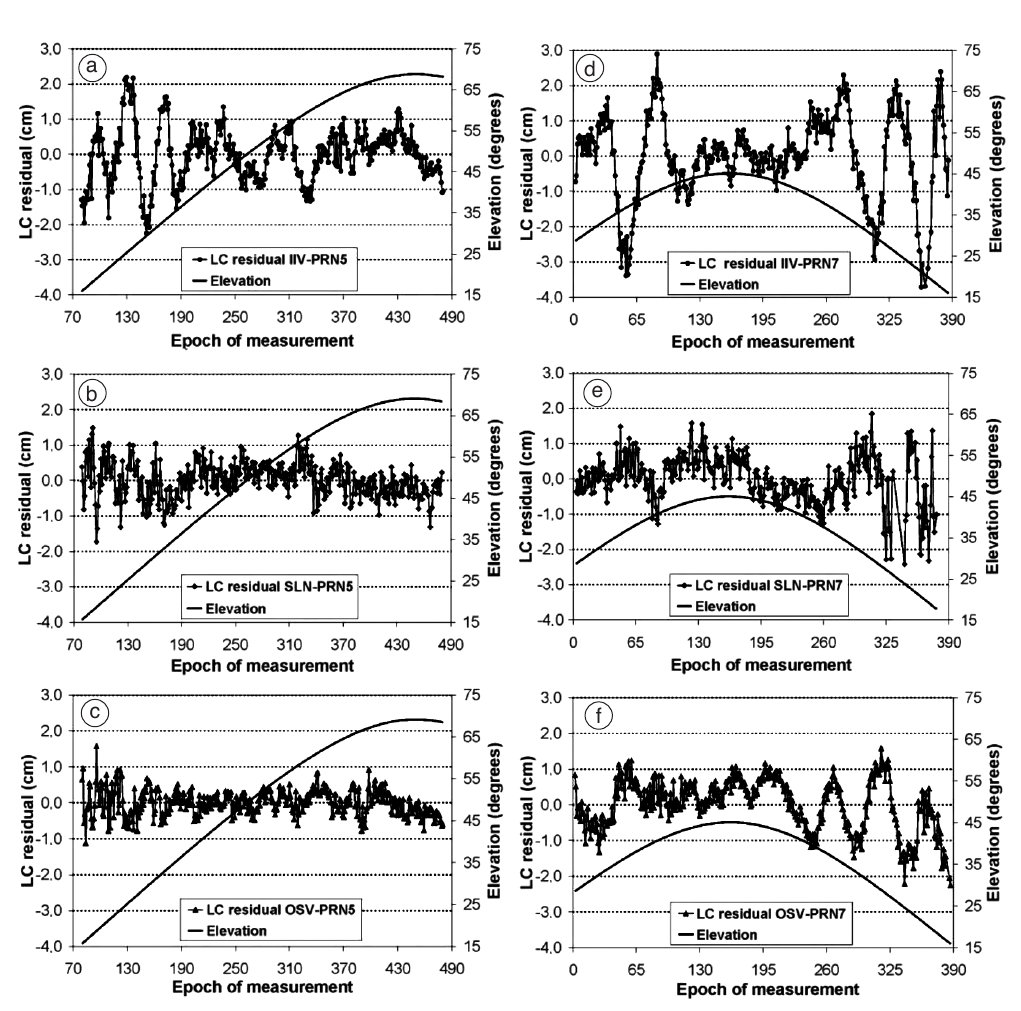
Fig. 6a-f. Residuals for the satellites PRN5 and PRN7 and the stations IIV, SLN and OSV with respect to the epoch of measurement; in the secondary ordinate axes the elevation angles of satellites are reported. For brevi- ty’s sake, we have omitted plots corresponding to the other visible satellites (PRN9, PRN23,